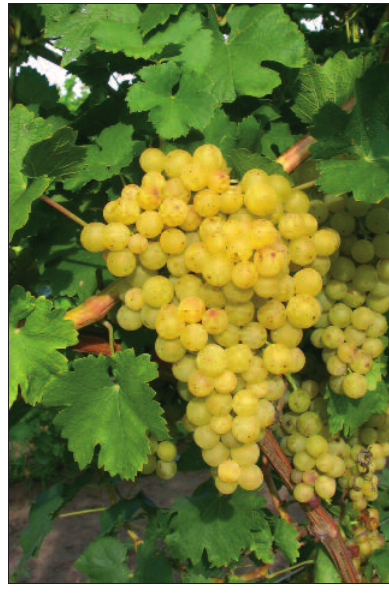
Fig. 13. Irsai Olivér K.11 Fig. 14. Kövidinka K.8 Fig. 12 . Hárslevelû K.9